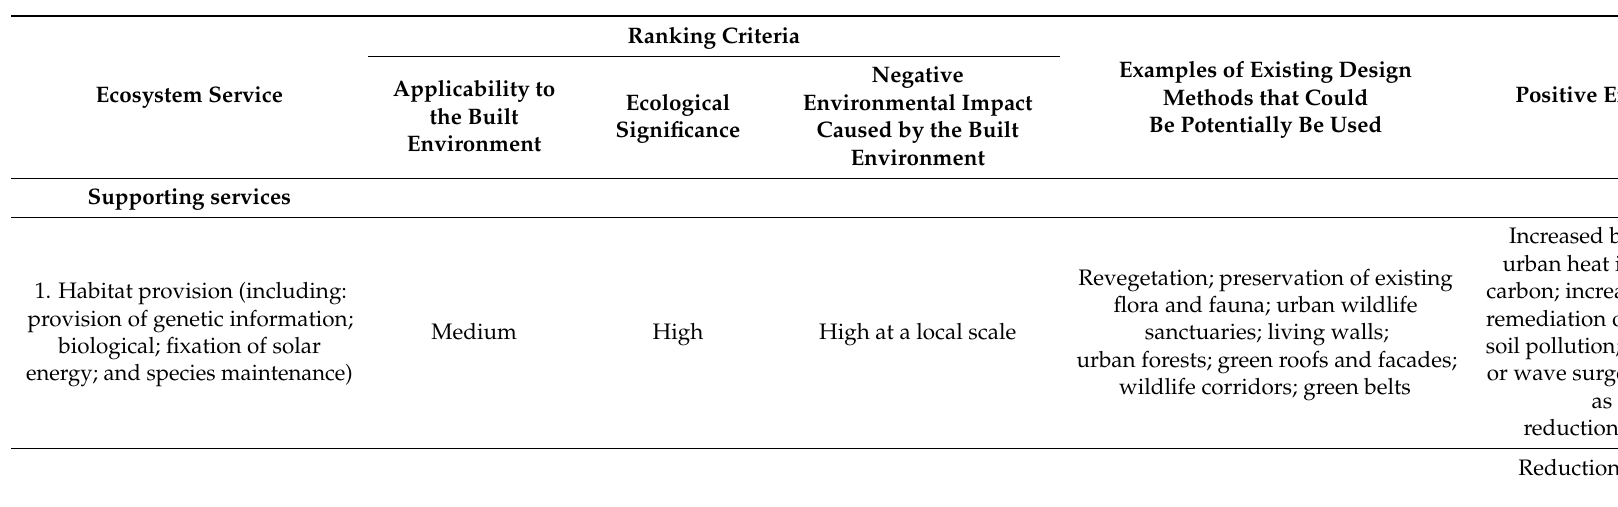
Table A1. Ecosystem services for the built environment